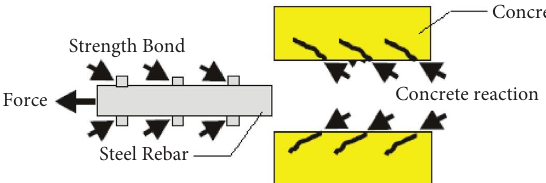
Figure 7: Bond strength between steel rebar and concrete surrounding [44].